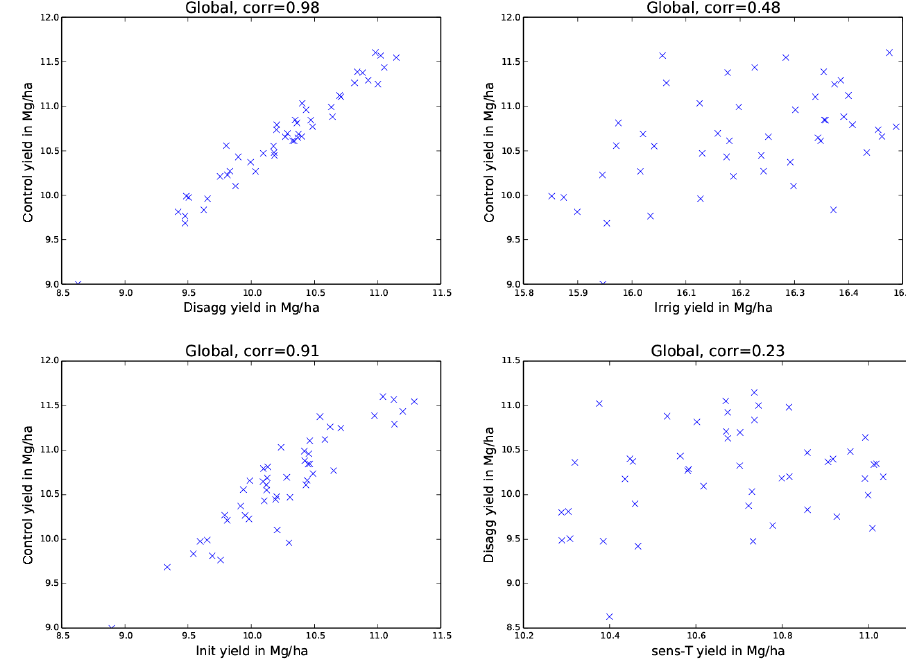
Figure A1. Scatter plots comparing the global mean maize yield from different model runs.